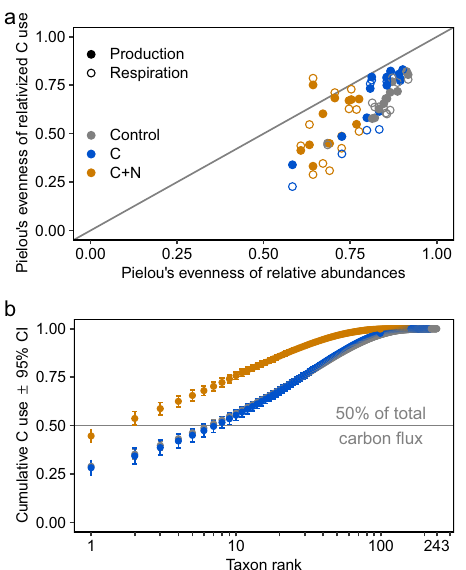
Fig. 3 Change in bacterial taxonomic and functional evenness across soil nutrient amendments. Color indicates soil treatment (Control = no amendment, C = glucose, C + N = glucose and [NH 4 ] 2 SO 4 ). a Pielou ’ s evenness of bacteria by relative abundance against Pielou ’ s evenness by relativized carbon (C) use. Closed circles represent evenness of biomass production, open circles represent evenness respiration. b Cumulative contribution of bacteria to total relativized C use across soil amendment ( n = 12 experimental